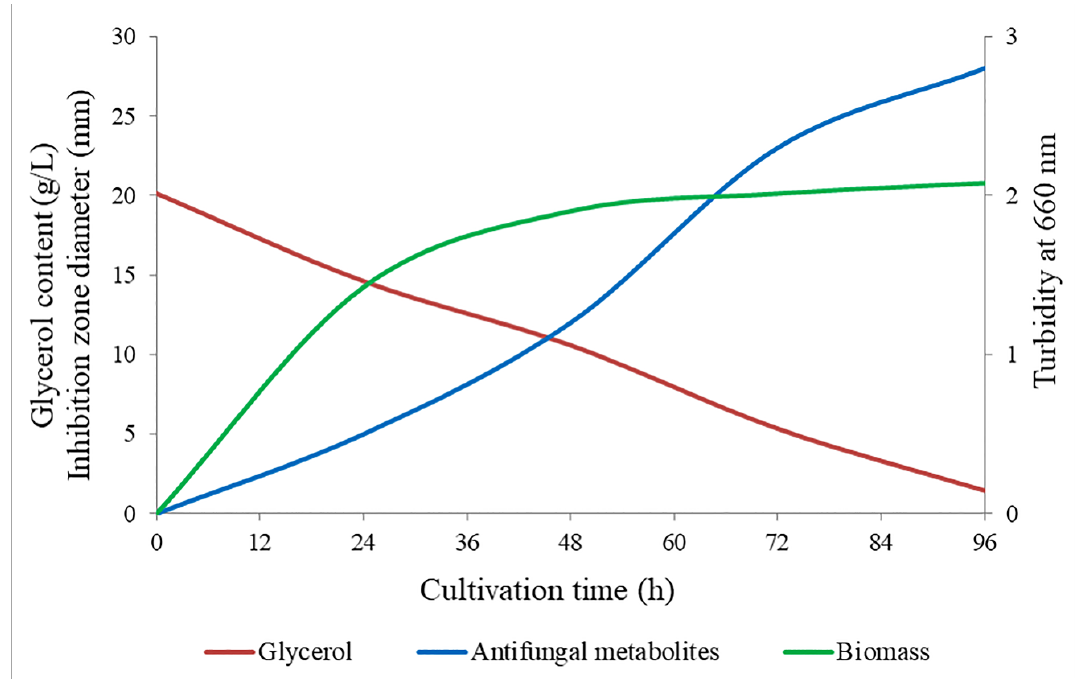
FIGURE 6 - Biomass growth, glycerol consumption and production of antifungal metabolites effective against Neurospora crassa during the cultivation of Bacillus subtilis ATCC 6633 on optimal